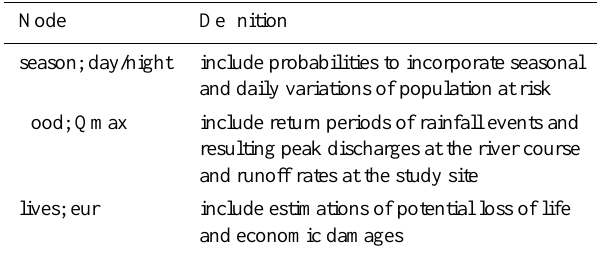
Table 2. Nodes for Risk Model